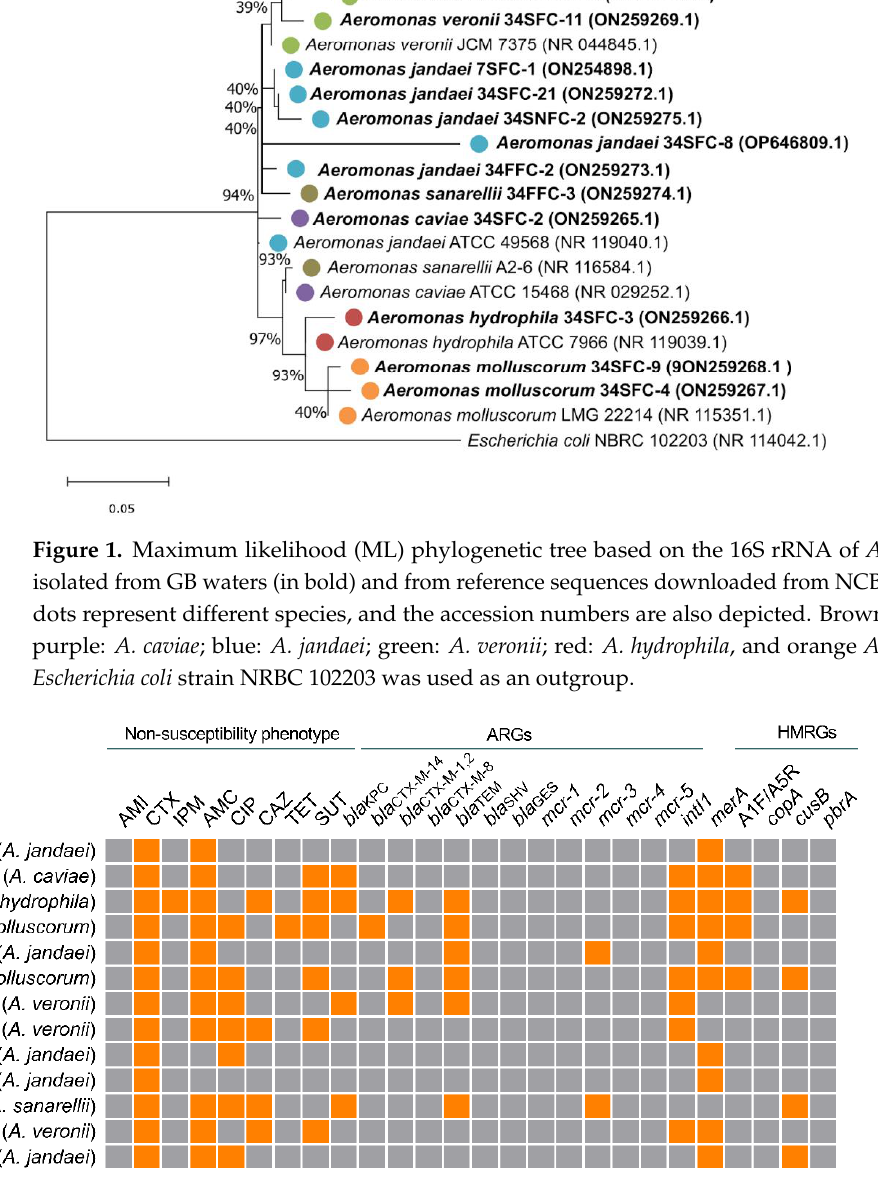
Figure 2. Antimicrobial susceptibility profile of the thirteen strains of antimicrobial-resistant Aeromonas from GB waters (Rio de Janeiro, Brazil), as well as the results of the detection of antimicrobial and heavy metal resistance genes (ARGs and HMRGs) and the integron-integrase gene ( intI1 ). AMI: amikacin; CTX: cefotaxime; IPM: imipenem; AMC: amoxicillin-clavulanic acid; CIP: ciprofloxacin; CAZ: ceftazidime; TET: tetracycline; SUT: trimethoprim-sulfamethoxazole. Orange squares indicate positive PCR results, while gray squares indicate negative results.